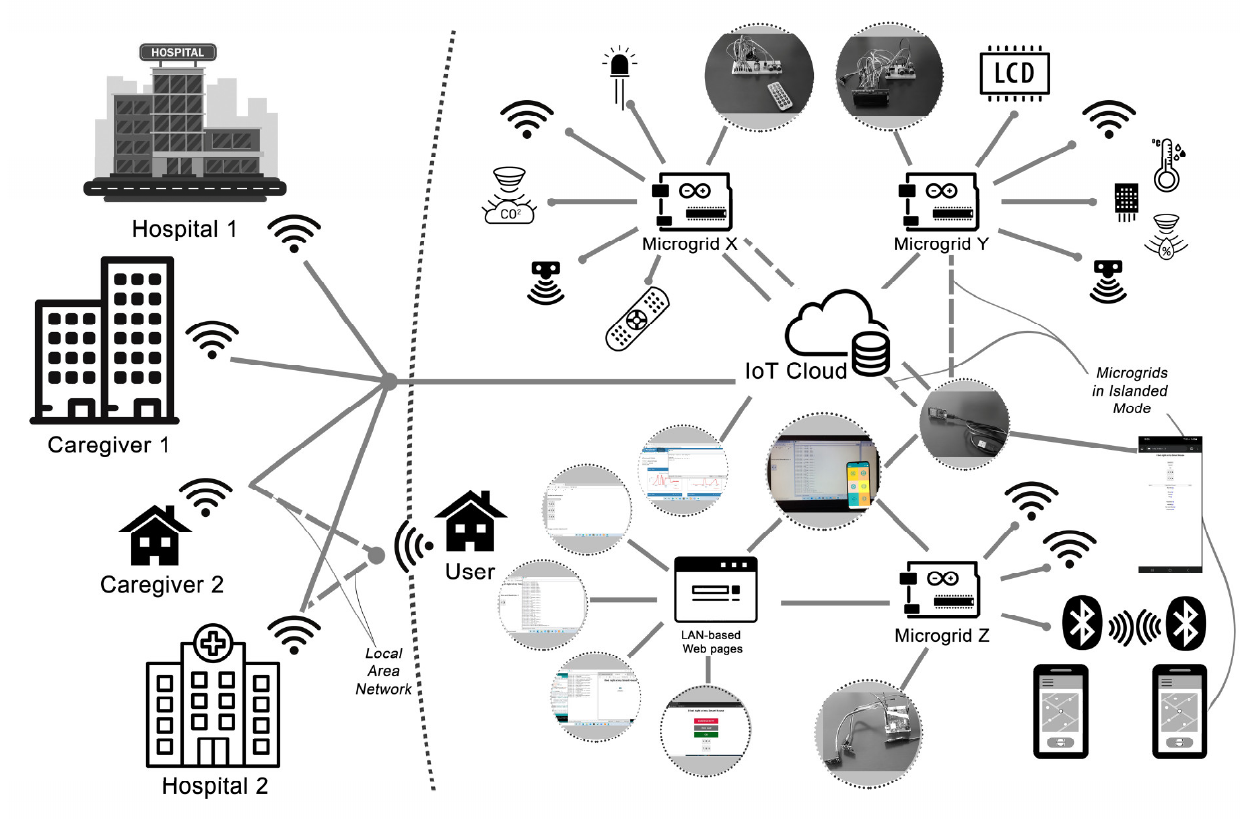
Figure 3. Nodes of sensors and communication schemata of the microgrids.